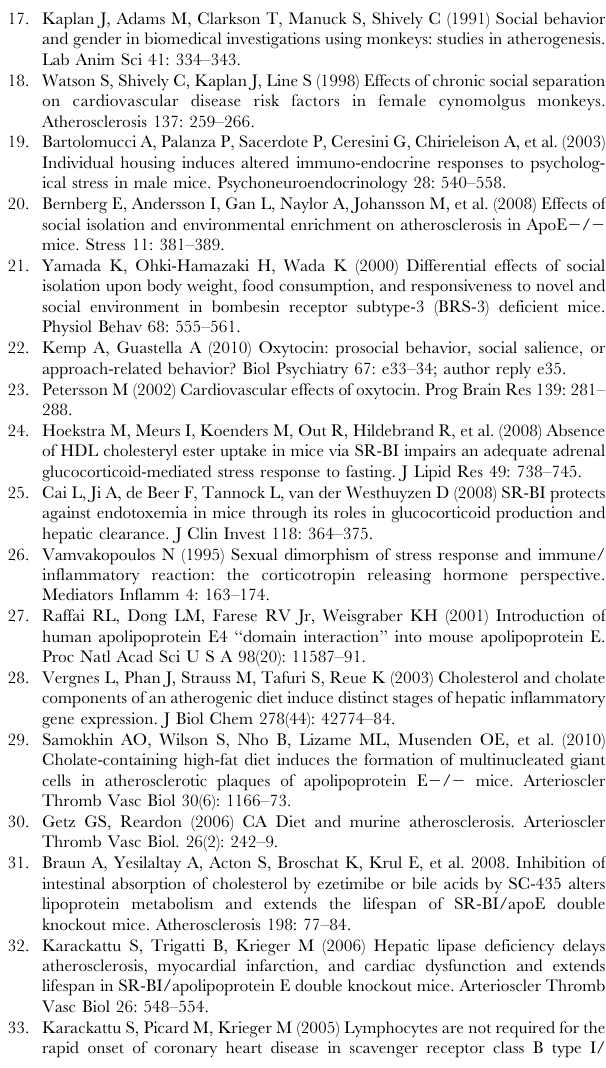
Figure S3 Relationships between plasma levels of oxytocin and corticosterone. HypoE mice were housed in mixed genotype groups (HypoE and one or more SRBI +